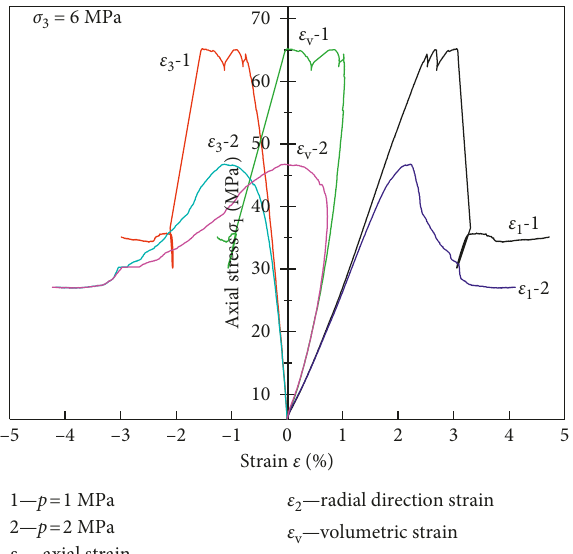
Figure 4: Relationship between stress and strain at different pore